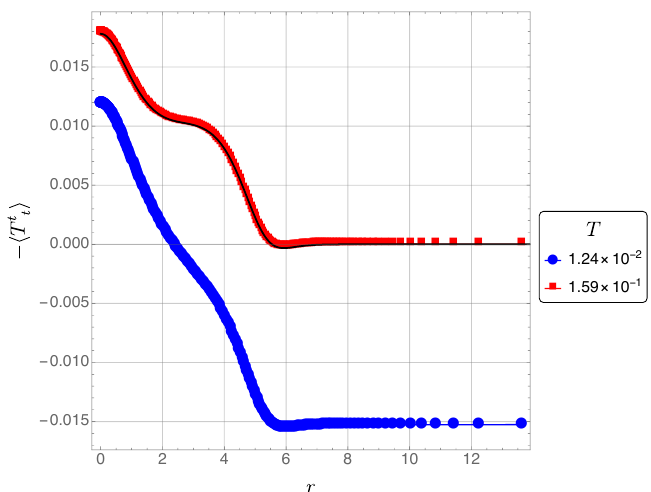
Figure 14 . Energy density as a function of the boundary proper distance r , computed with (cid:22) = 3, p (cid:23) = 8 3 = 5 (same parameters as in (cid:12)gure 12). The solid black line corresponds to the analytic solution eq. (4.14), and the red squares and blue disks to numerical data. The temperatures used are indicated in the legend